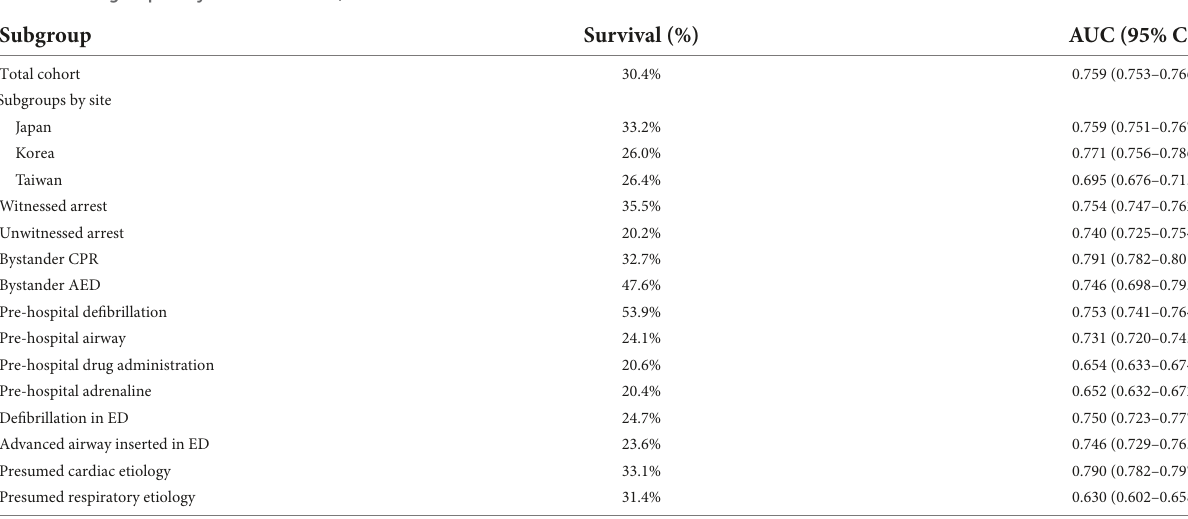
TABLE 3 Subgroup analysis–survival rate, area under the